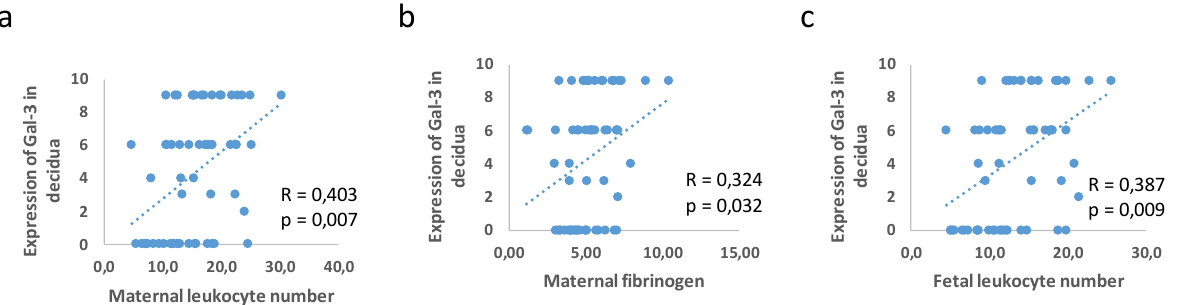
Figure 8. Correlation in expression of Gal-3 in decidua and leukocyte number in maternal blood ( a ), maternal fibrinogen ( b ), and leukocyte number in fetal blood ( c ). The IL-1 β expression in the decidua was in correlation with the maternal and fetal leukocyte number (maternal blood R = 0.557; p = 0.00; fetal blood R = 0.458; p = 0.001), CRP (maternal blood R = 0.451; p = 0,001; fetal blood R = 0.403; p = 0.003), and fibrinogen (maternal blood R = 0.357; p = 0.009; fetal blood R = 0.344; p = 0.012), as shown in Figure 9. There was no correlation between the clinical parameters and expression levels of IL-1 β in the fetal membranes and NLRP3 in all of the examined tissues.